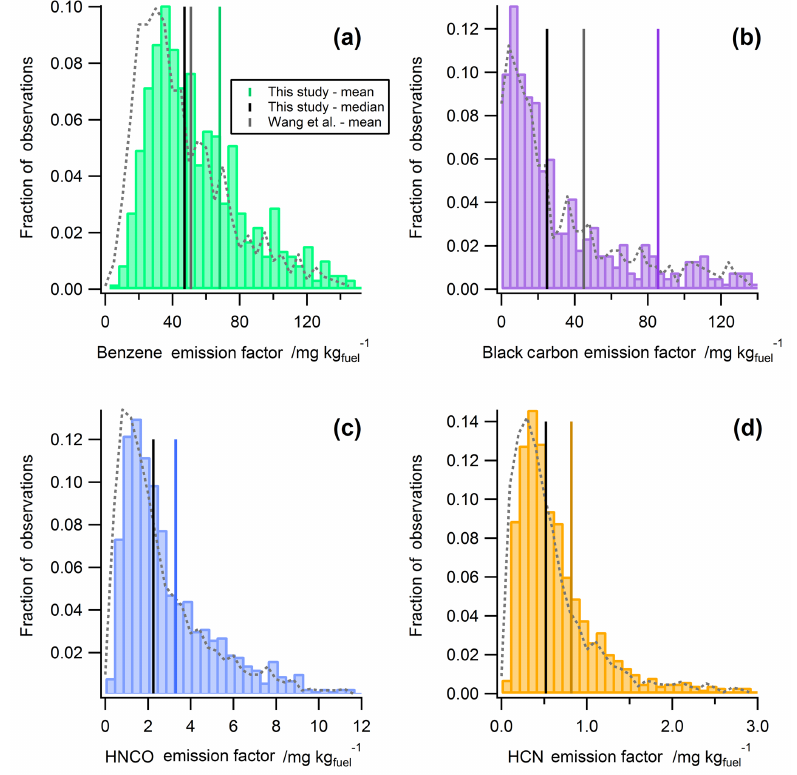
Figure 4. Plume-based emission factors obtained by CRUISER for (a) benzene, (b) BC, (c) HNCO, and (d) HCN for the SPP case (colored bars) and the MPP case (grey, dashed line). The median and mean EF values are indicated by the vertical black and colored lines respectively. Where available, the mean EF obtained by Wang et al. (2015) is indicated by the vertical grey